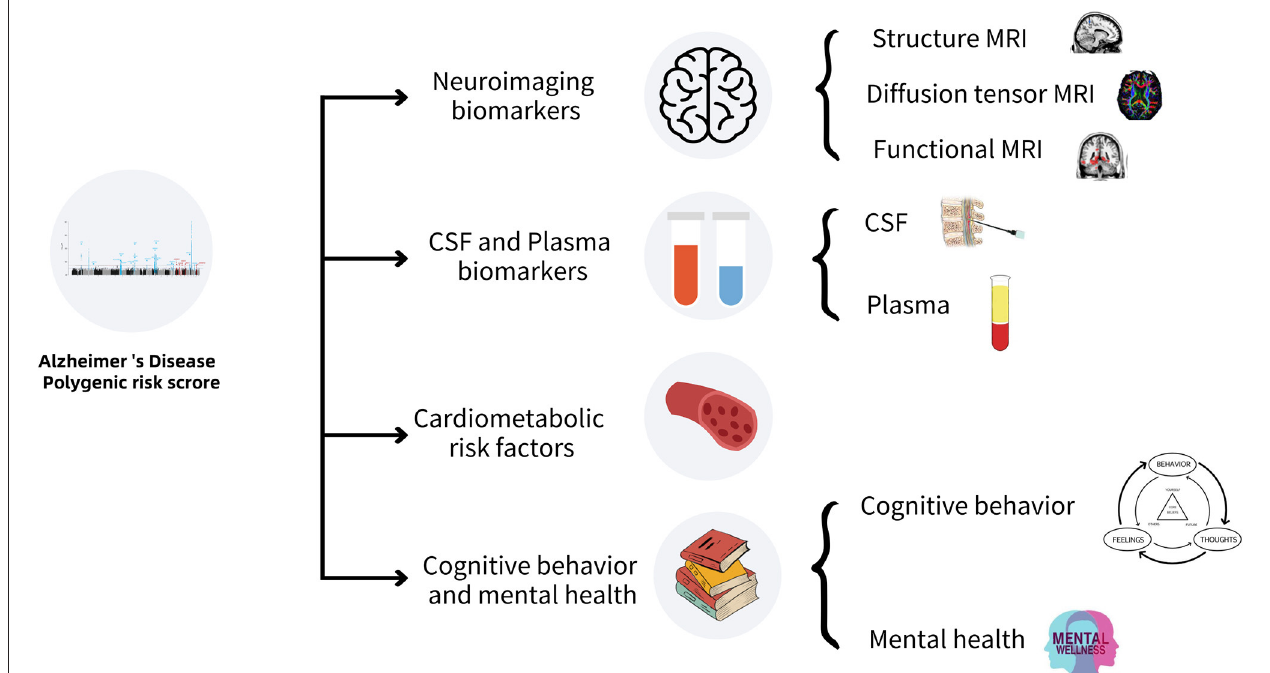
FIGURE 1 | Association of AD-PRS with various biomarkers for